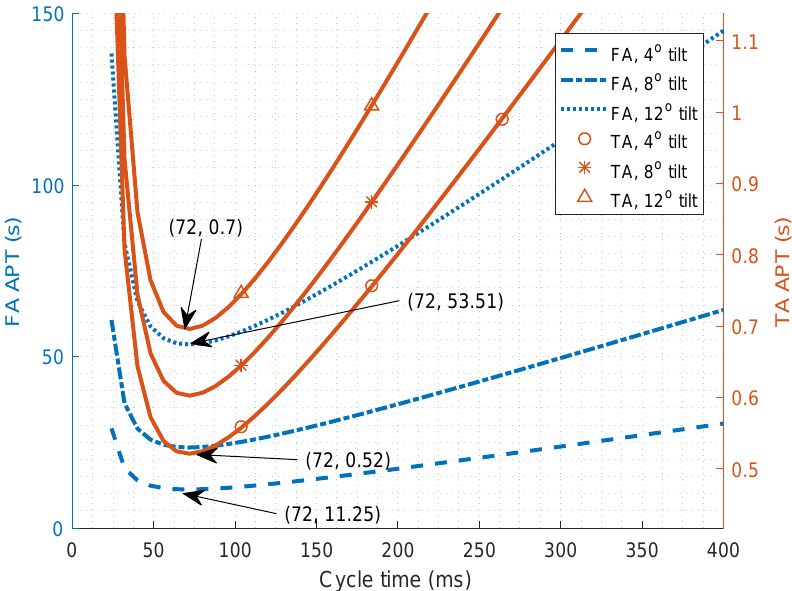
Figure 15. Reduction of the effect of receiver tilt on APT in 4-bit packets through the use of receiver defined threshold angle (TA) instead of the conventional full angle (FA).